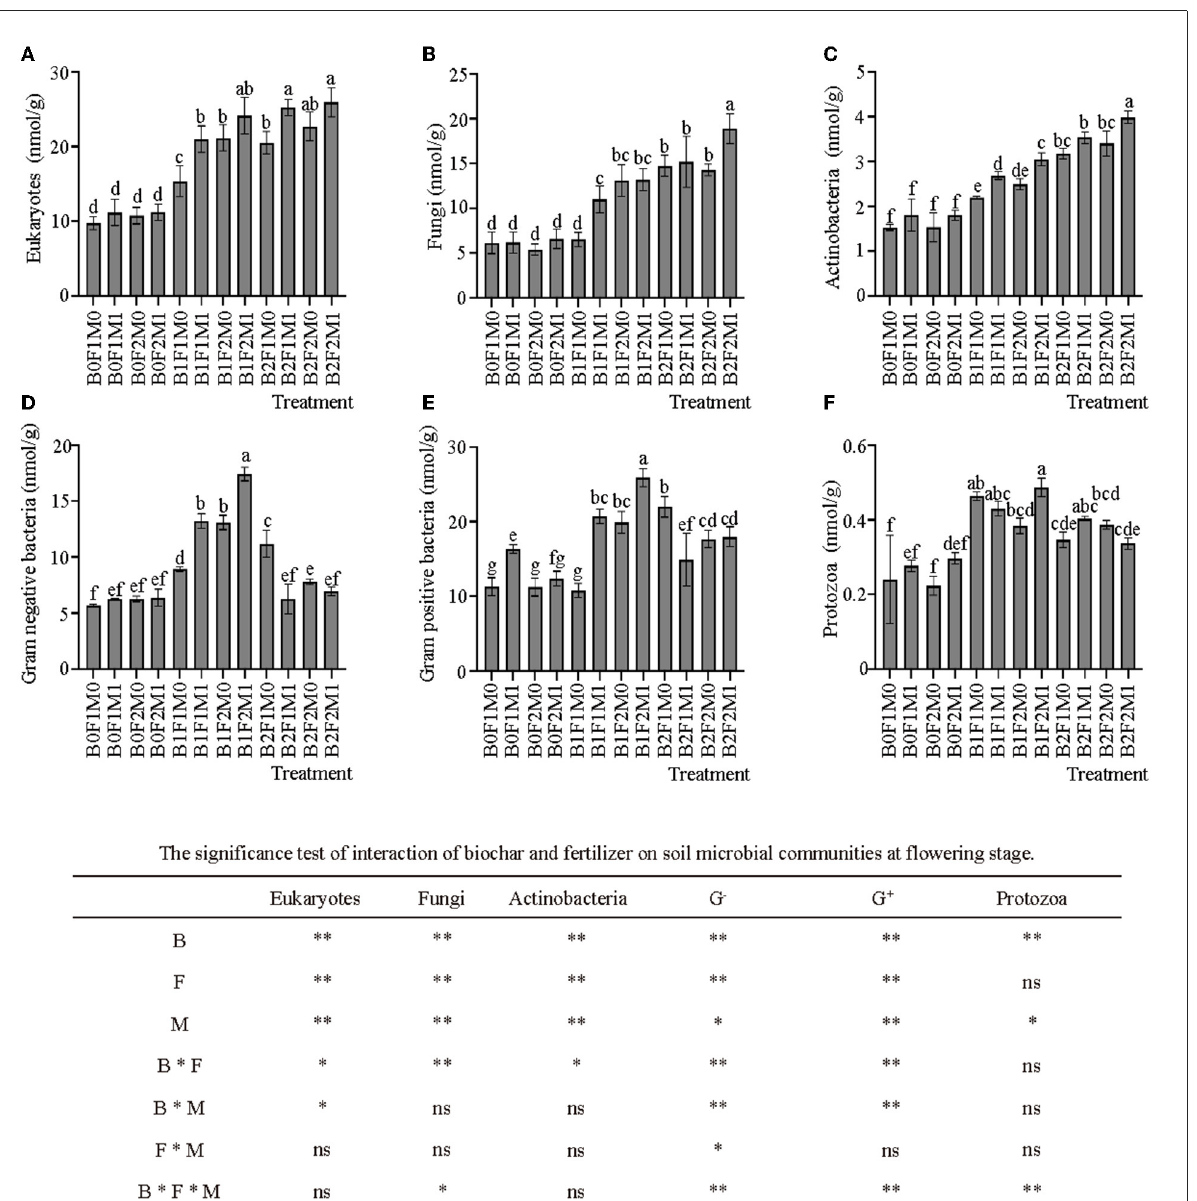
FIGURE6 Effects of biochar, inorganic fertilizer and organic fertilizer on soil microbial communities at flowering stage (A–F) . Bars followed by the same letter are not significantly different according to LSD-test ( P ≤ 0.05). Bars represent standard errors of the means. * and ** Significant difference at p = 0.05 and p = 0.01, respectively, and ns indicates no significant